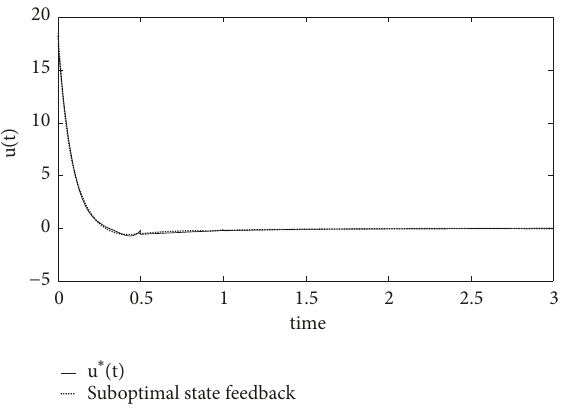
Figure 7: Optimal and suboptimal control signals for the chemical